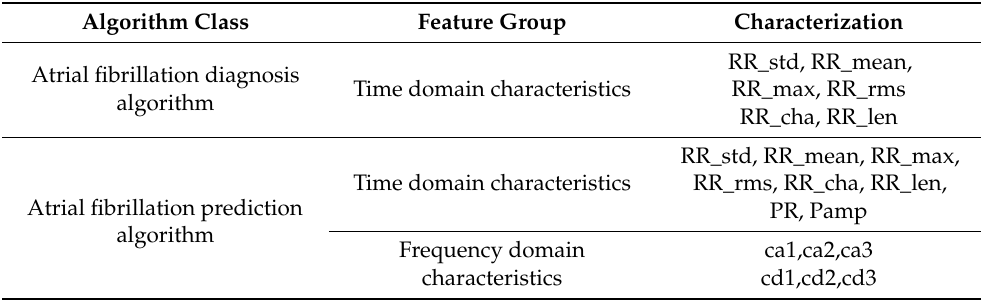
Table 2. Predicted characteristics of atrial